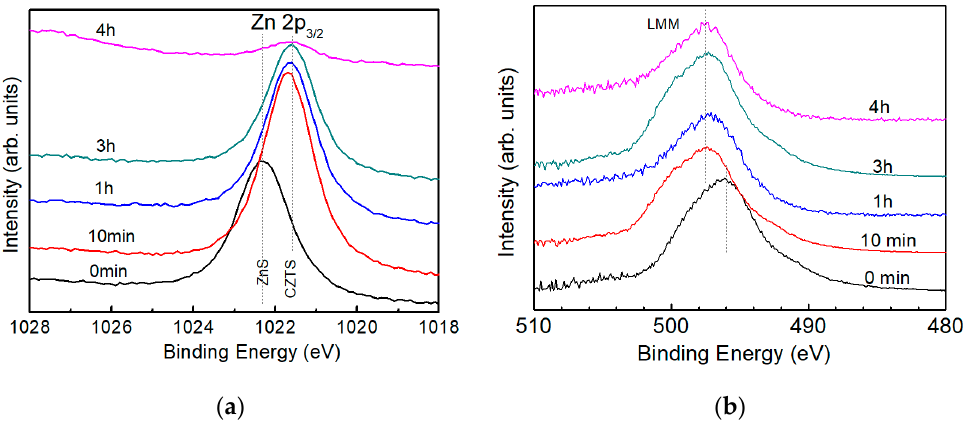
Figure 6. ( a ) XPS spectra of Zn 2p 3/2 and ( b ) Auger electron spectra of Zn LMM of a CZTS film. Dotted lines in ( a ) indicate the peak positions of ZnS and CZTS and in ( b ) indicate the peak positions of the spectra.